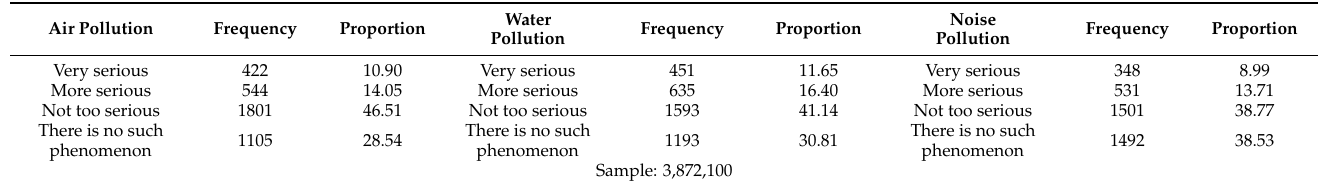
Table 3. Description and analysis of environmental pollution perception (Unit: Pcs,